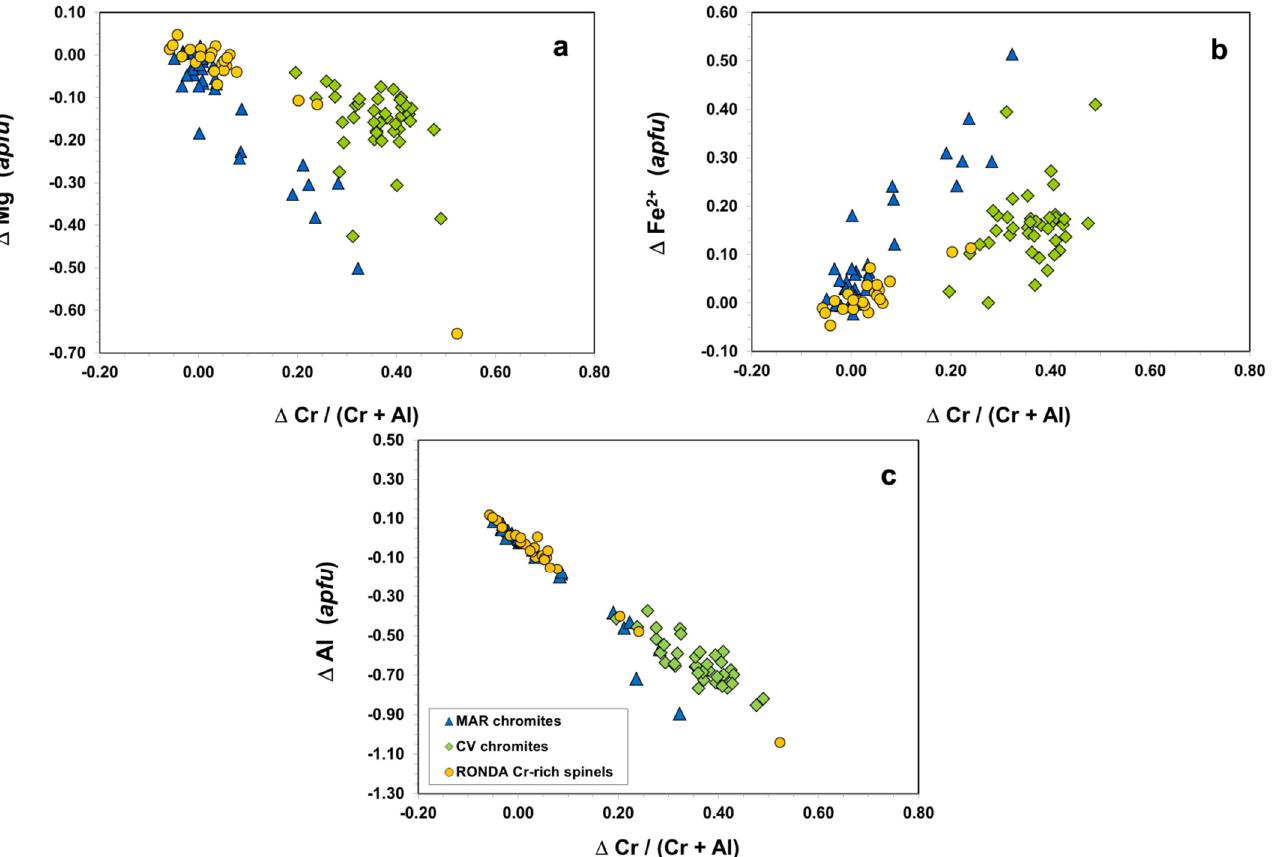
Figure 10. Variation of ( a ) Mg, ( b ) Fe 2+ and ( c ) Al contents with increasing Cr/(Cr + Al) ratios in the MAR magnesiochromites, CV chromites and Ronda chromian spinels.